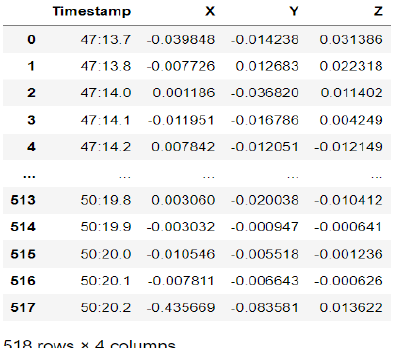
Figure 57. Merged gyroscope (angular velocity) sensor data.